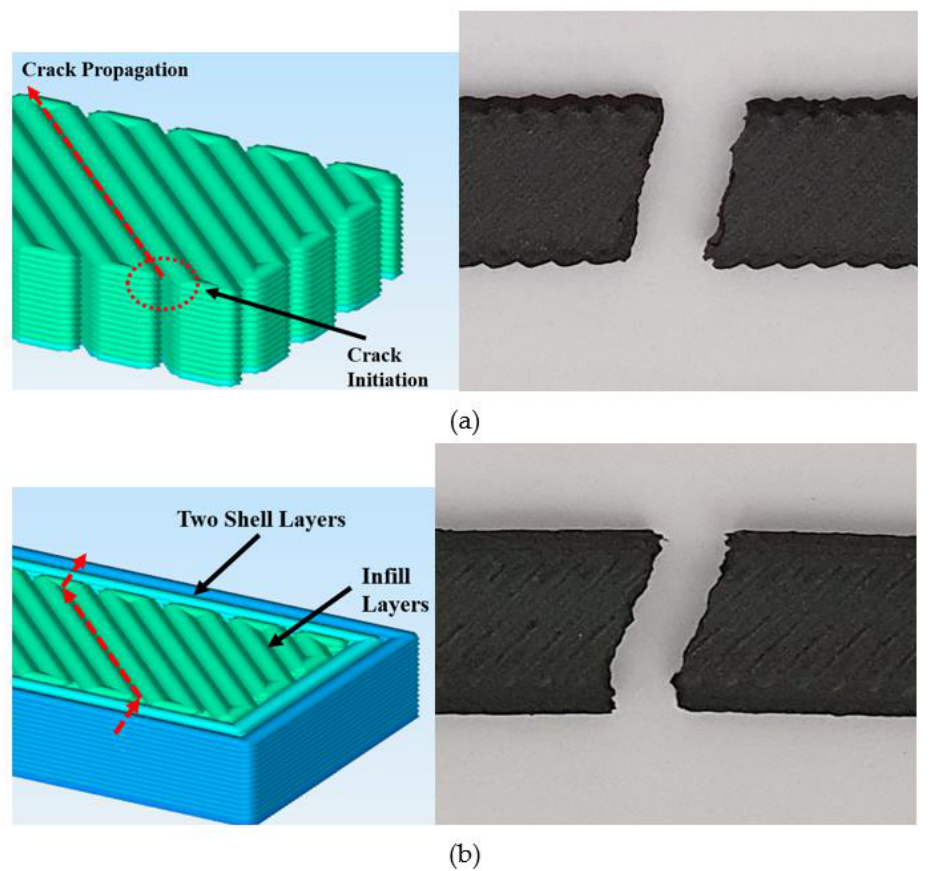
Figure 5. Crack initiation and propagation in the 45° raster angled of the framed and non-framed samples. ( a ) Non-framed. ( b ) Framed.